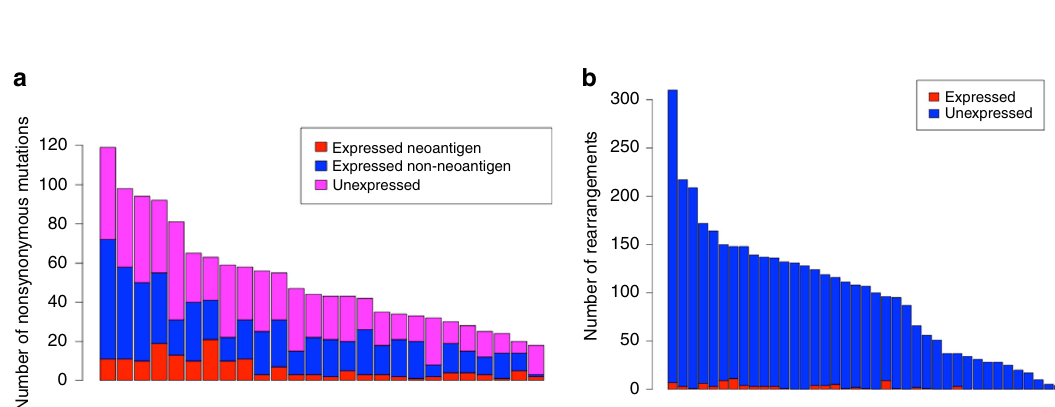
shown in asterisks. e Pearson correlation between normalized telomere length and number of copy number segments of samples. f Pearson correlation between normalized telomere length and ATRX gene expression level (in log2 scale) of samples. Samples with both ATRX and TP53 alterations, ATRX alterations alone, and TP53 alterations alone were respectively marked as red, blue, and green color.